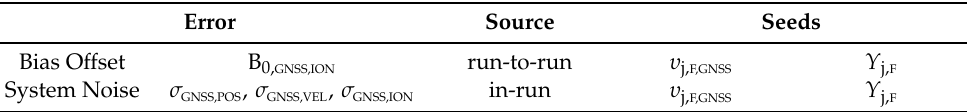
Table 7. GNSS receiver error